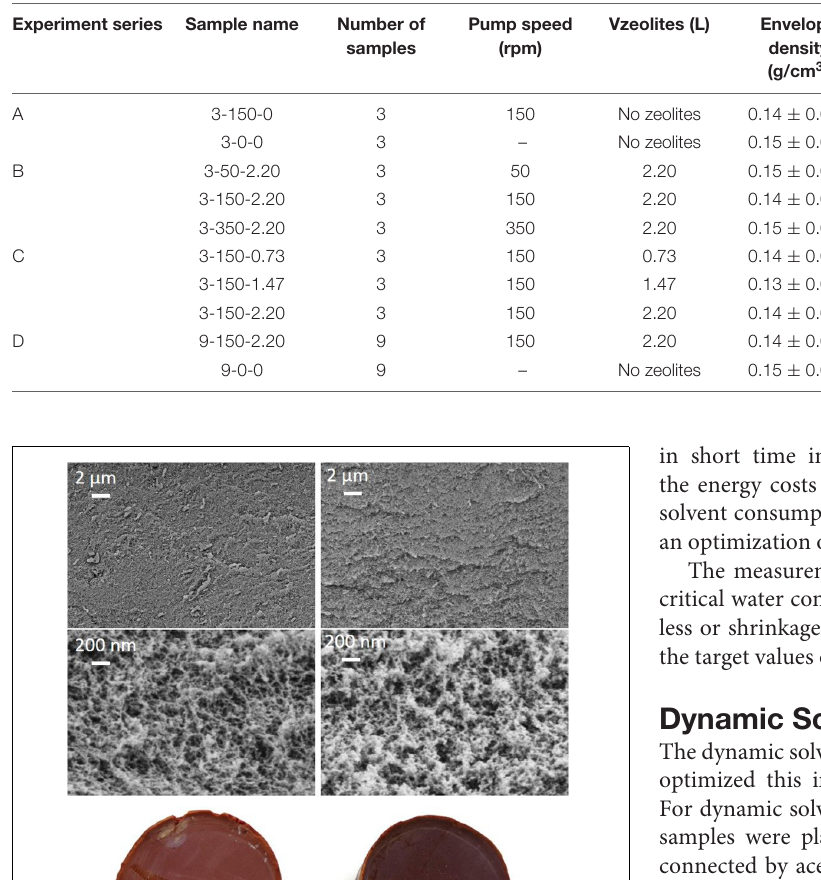
TABLE 1 | Washing conditions and material properties of the RF aerogels.